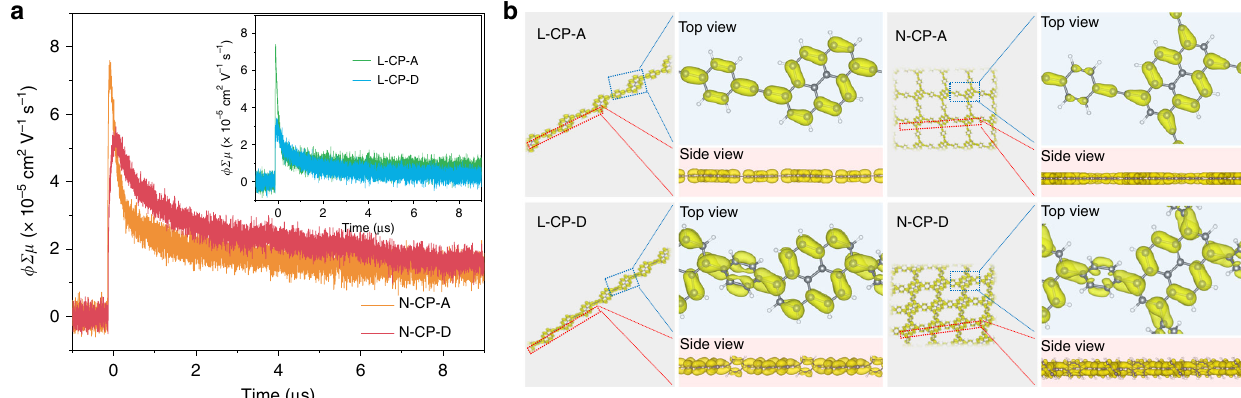
Fig. 2 Characterization of electronic delocalization in CPs. a Conductivity transients observed by fl ash-photolysis time-resolved microwave conductivity (FP-TRMC) spectroscopy upon excitation at 355 nm laser pulses at 1.8 × 10 16 photons cm − 2 for CPs. b Top and side views of the charge distribution of LUMO of CPs at the Γ